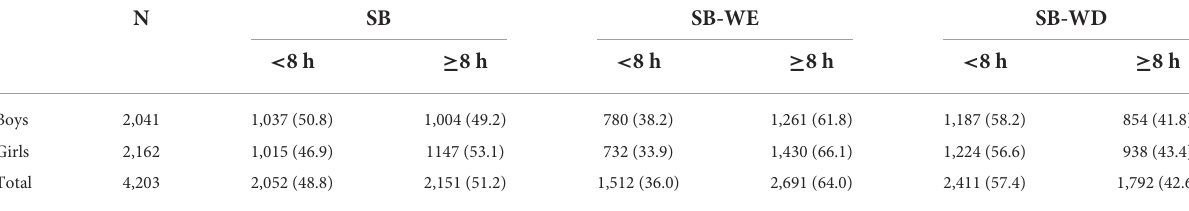
TABLE 7 Detection rate of high sedentary behavior in children and adolescents of different sex [ N (%)].